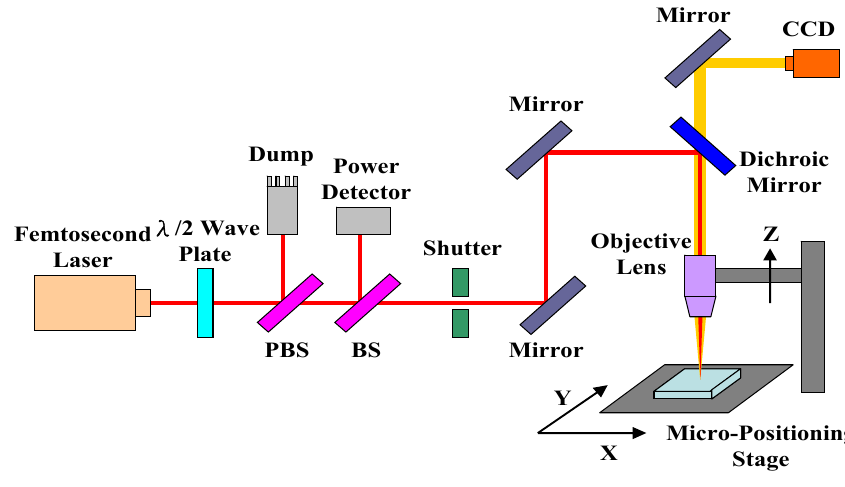
Figure 2. Experimental setup of a femtosecond laser micromachining